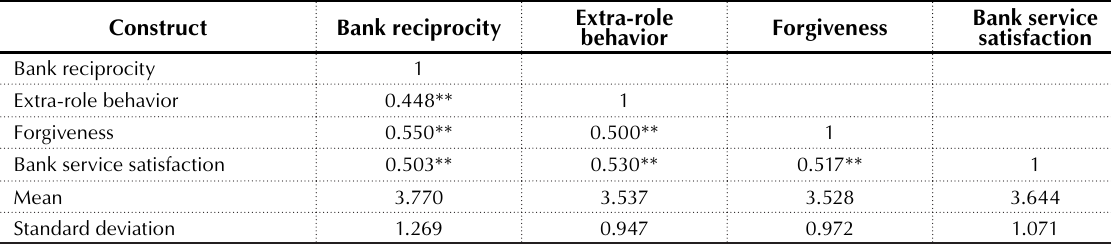
Table 2. Pearson correlation analysis results and descriptive measures